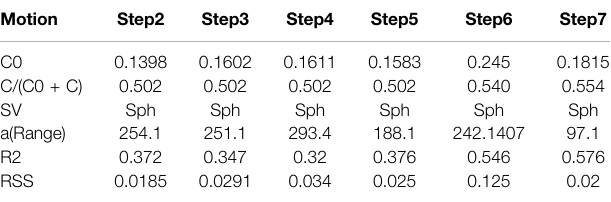
TABLE 2| Spatialvariabilityofrock block